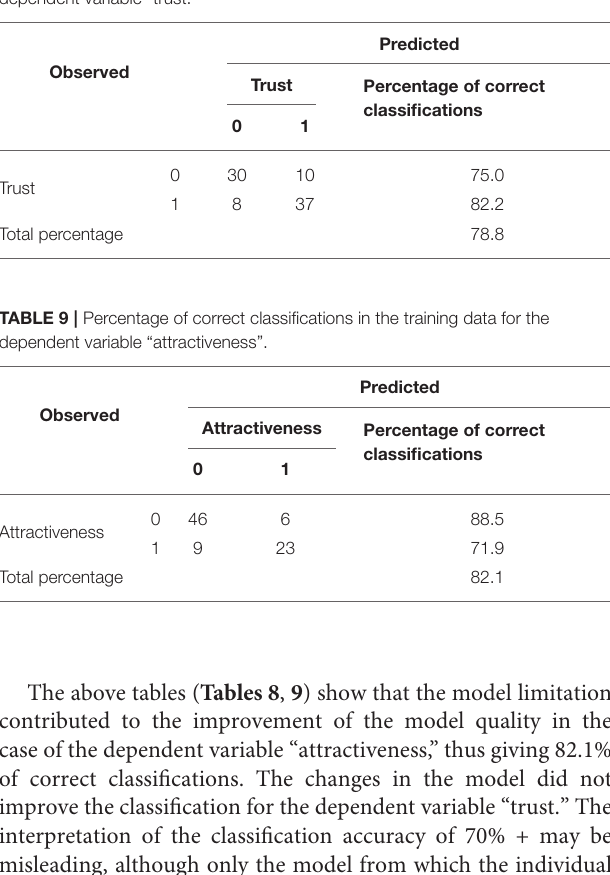
TABLE 8 | Percentage of correct classifications in the training data for the dependent variable “trust.”